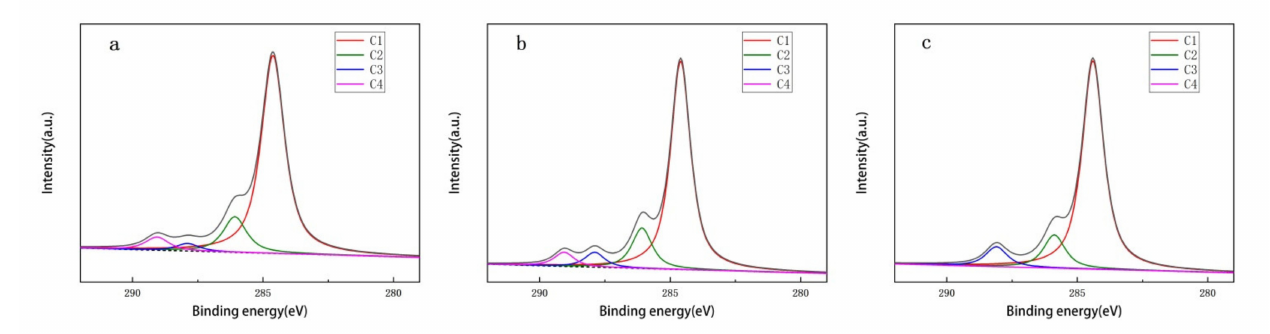
Figure 2. C1s XPS spectra of ( a ) RCB800, ( b ) BSB800, and ( c ) CSB800.